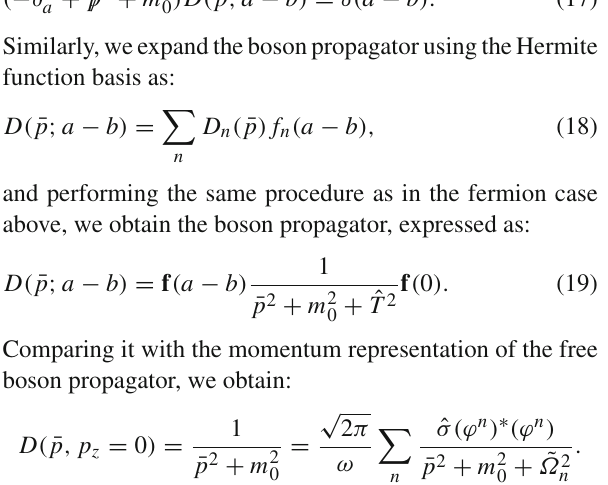
Fig. 1 The boson propagator obtained from the Hermite function basis expansion as in Eq. (20) compared to the free boson propaga- ) expanded on the plane wave basis, with two different tor 1 /( ¯ p 2 + m 2 0